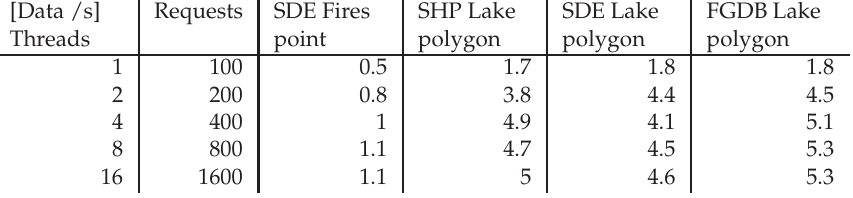
Table 5: WFS ArcGIS Server tests results. Refer to Table 4 for acronyms.